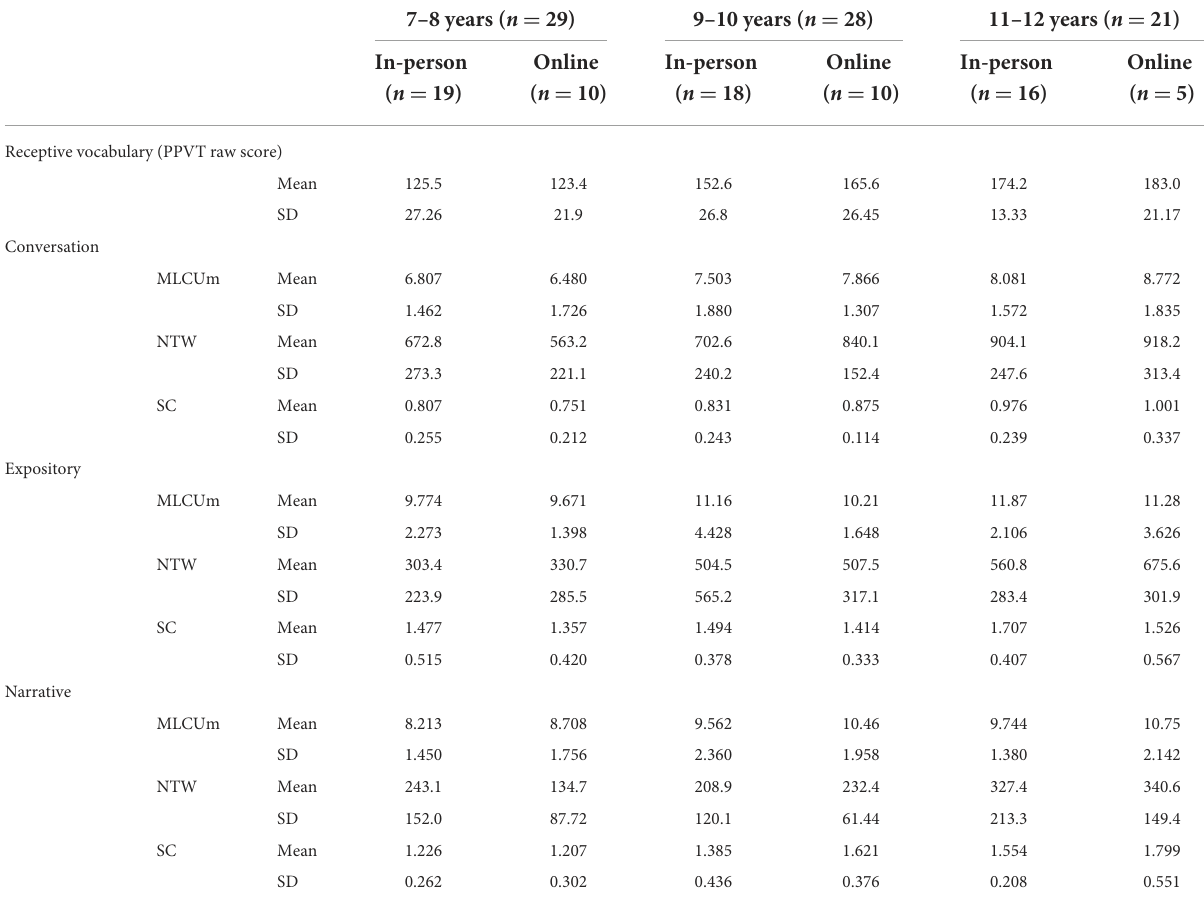
TABLE 3 Means and standard deviations of bilingual participants on all